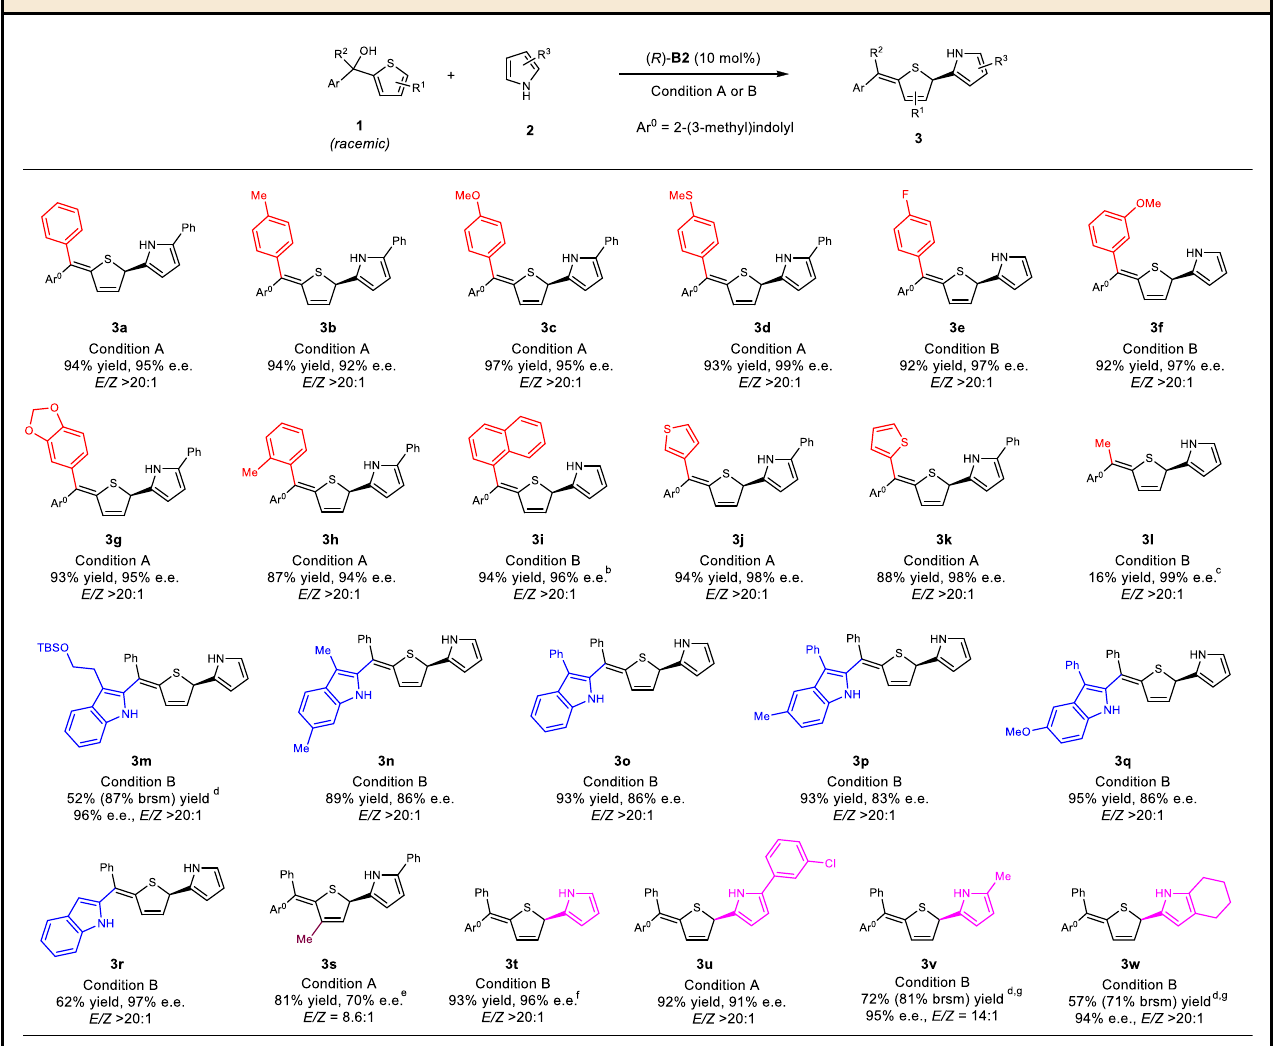
Table 2 Scope study on asymmetric dearomatization of thiophenes a